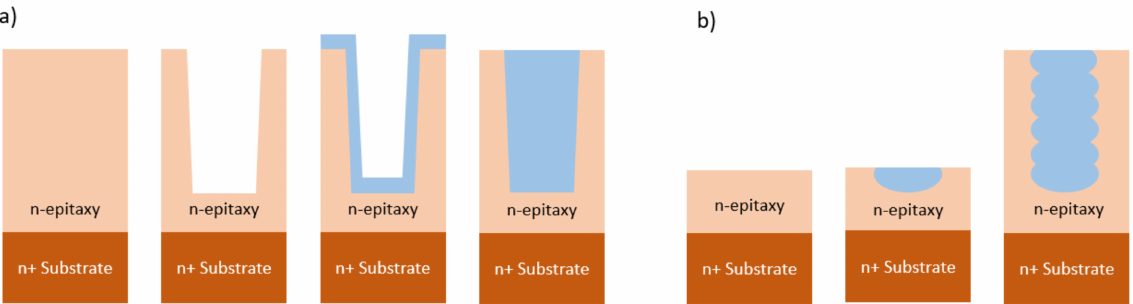
Figure 12. ( a ) Trench-filling epitaxial growth and ( b ) multi-epitaxial